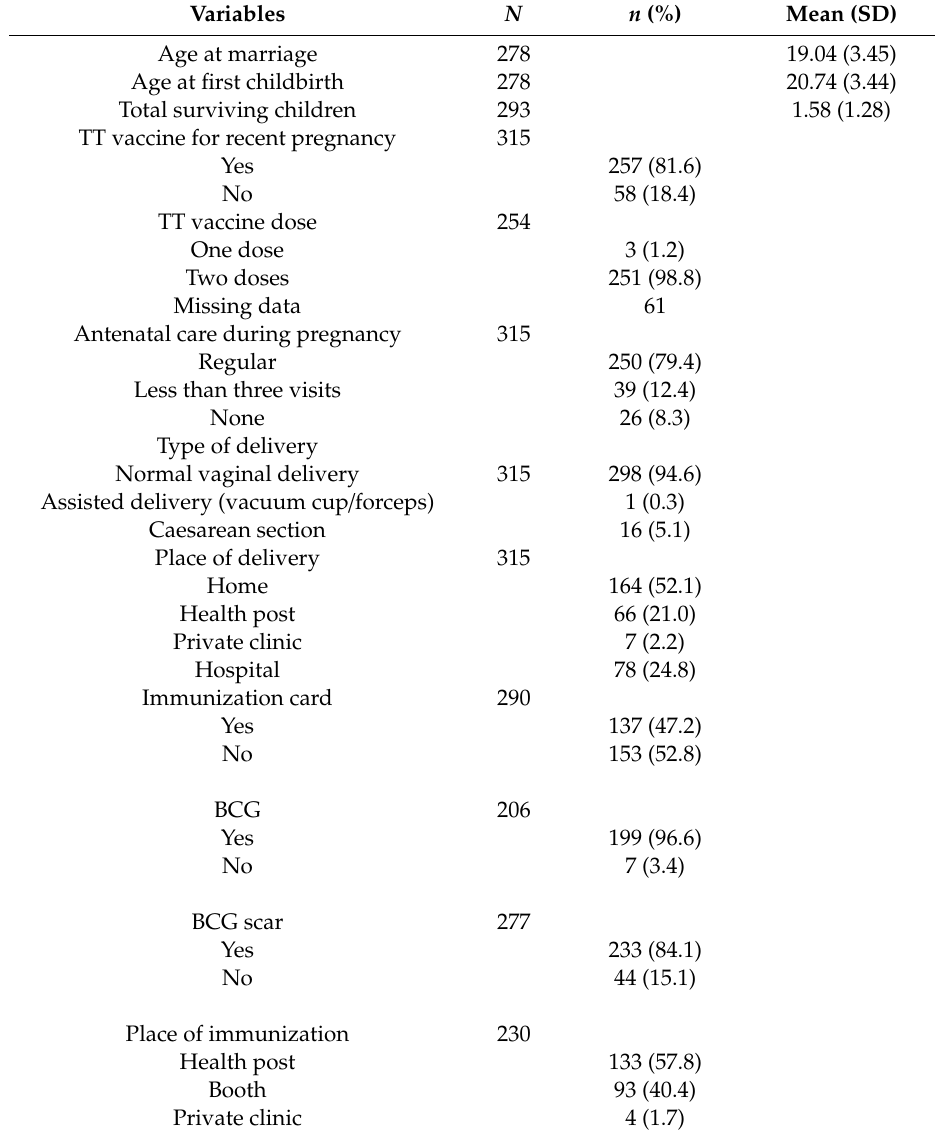
Table 3. Maternal and child health characteristics ( N =